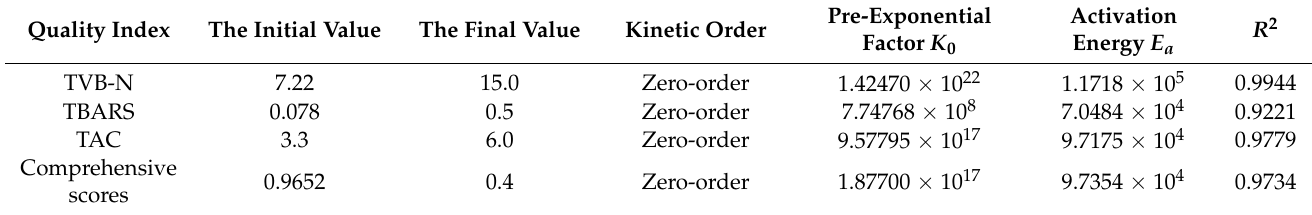
Table 3. The parameter of prediction model for the